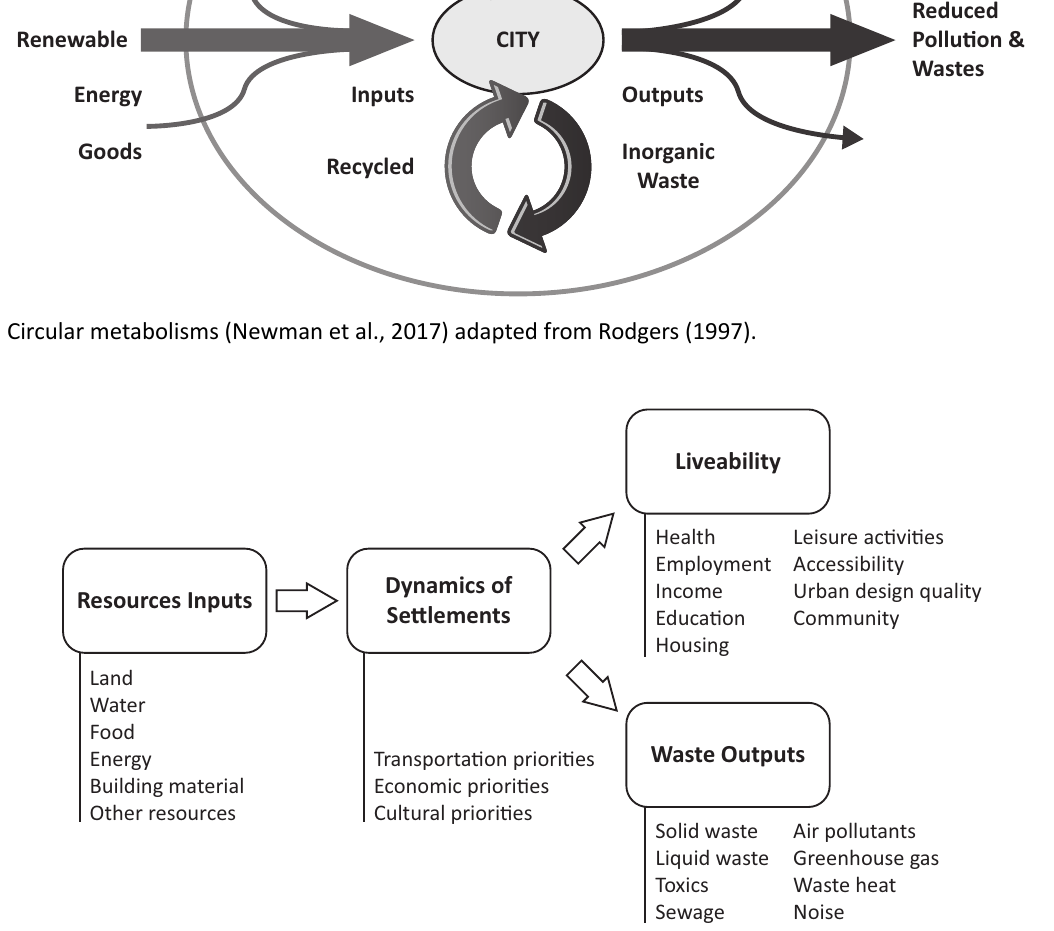
Figure 3. The extended metabolism model (Newman & Kenworthy,